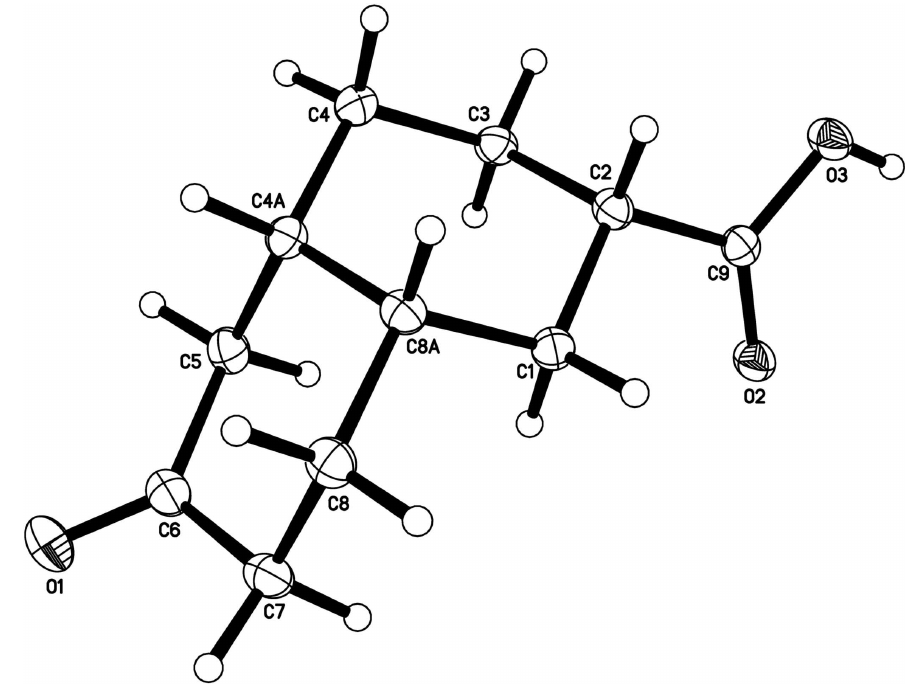
Figure 1 Molecular structure showing displacement ellipsoids at the 40% probability level for non-H